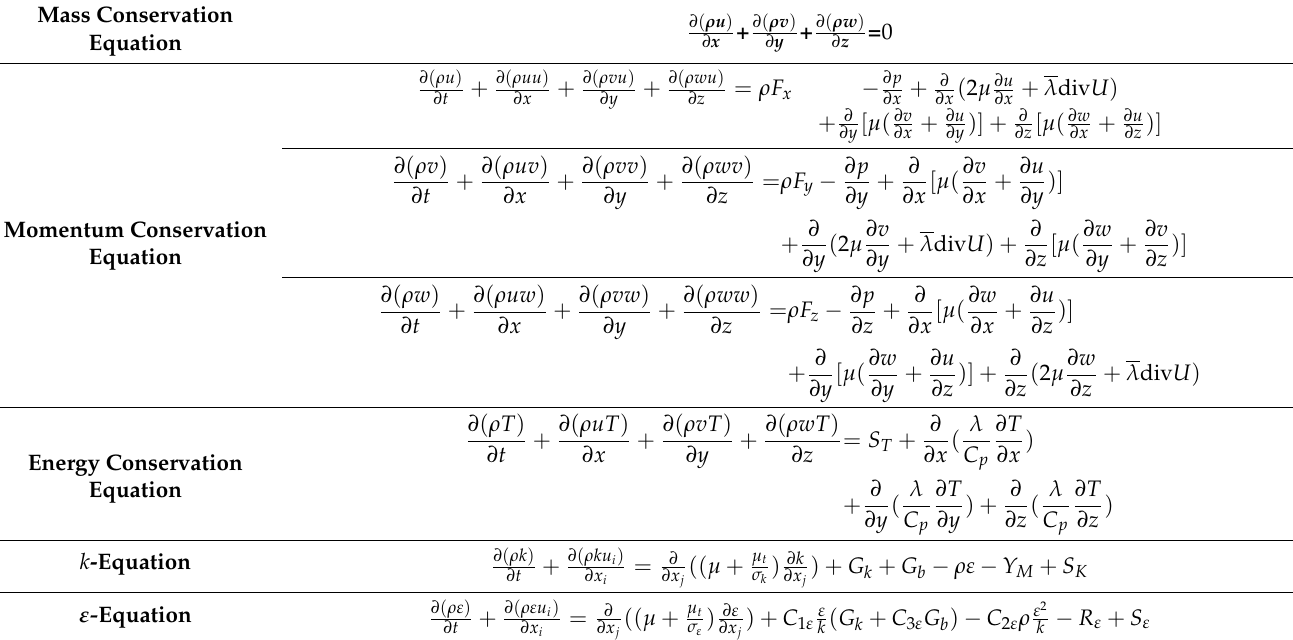
Table 1. Basic equations of fluid and heat transfer